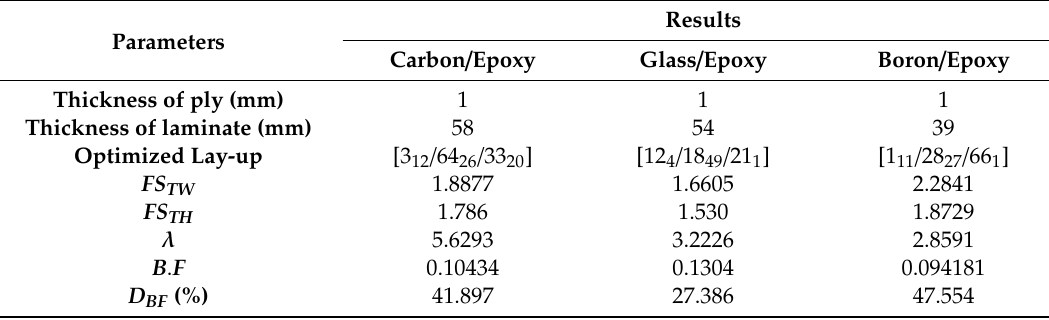
Table 8. Optimal lay-ups for [ β 1S / β 2T / β 3U ].